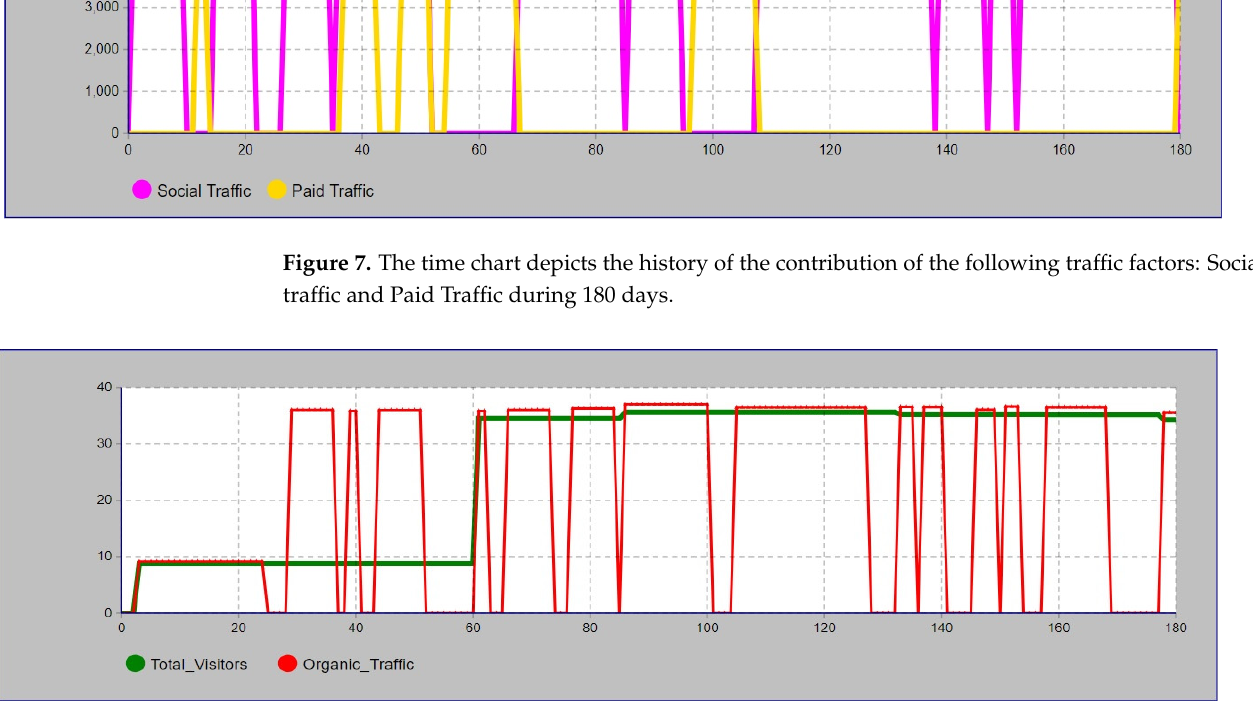
Figure 8. The time chart depicts the history of the contribution of the following visibility factors: Organic traffic and Total visitors during 180 days.